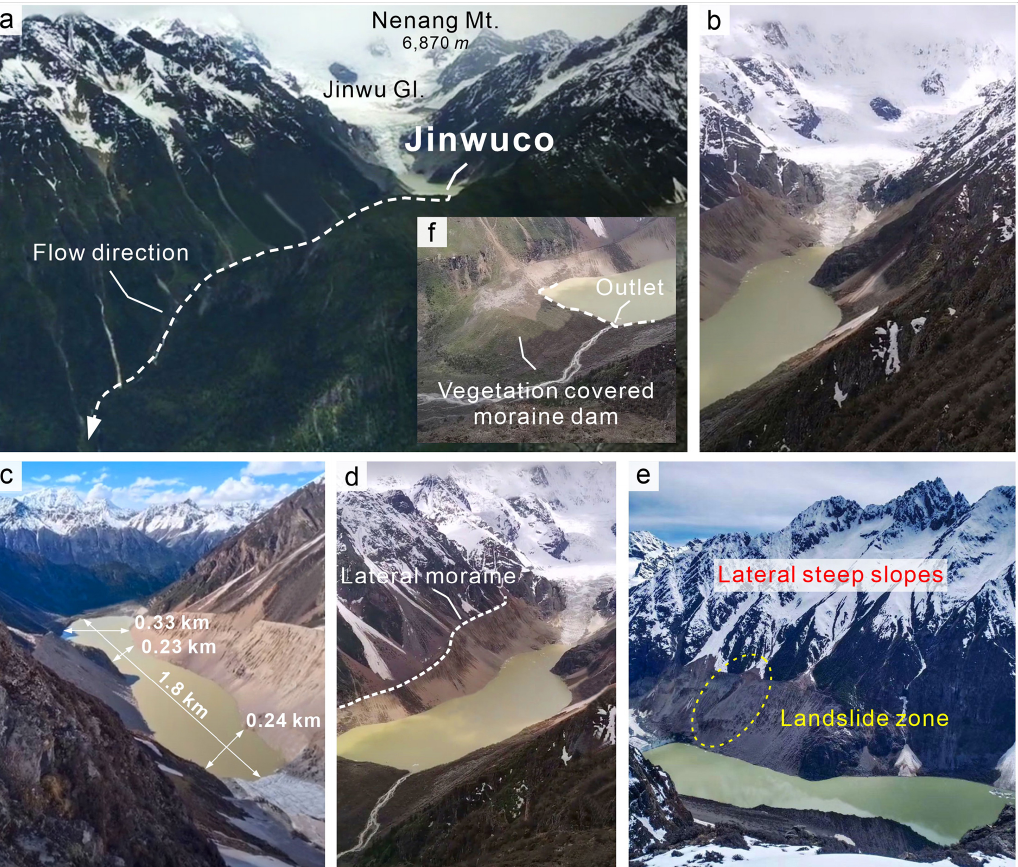
Figure 2. Overview of Jinwuco before the collapse of the dam. (a) An overall view of Jinwuco and surroundings taken from the opposite valley on 19 June 2020. (b) Crevassed hanging glacier ice terminated in Jinwuco, taken from downstream to upstream of the lake on 11 June 2020. (c) Morphological parameters of Jinwuco; photo taken from upstream to downstream of the lake on 15 June 2020. (d) Lateral moraine and steep mountain slopes from west to east (11 June 2020) and (e) from east to west (30 May 2020). (f) Vegetation-covered moraine dam and the position of the outlet (11 June 2020). Photos: Qiangba Quying (used with